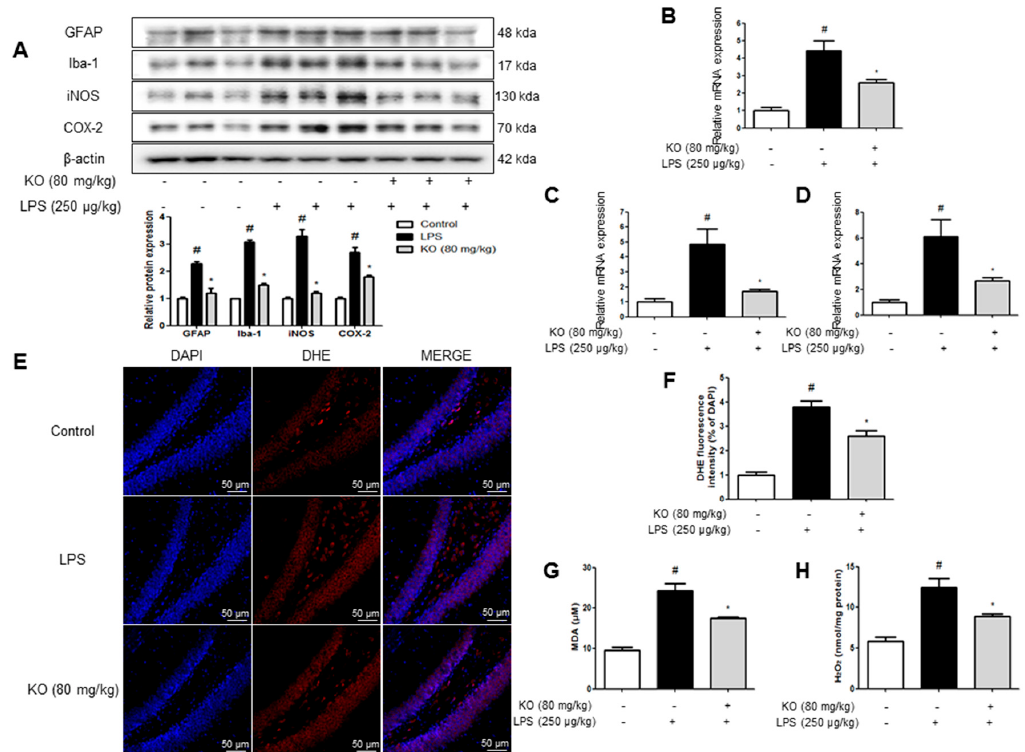
Figure 4. Effect of Krill oil on the LPS-induced neuroinflammation and oxidative stress in the mouse brain. The expression of GFAP, Iba-1, iNOS, and COX-2, were detected by Western blotting using specific antibodies in the mice brain. Each blot is representative of three experiments ( A ). For the cropped images, samples were run in the same gels under same experimental conditions and processed in parallel. The graphs under Western blotting are the relative protein expression of three bands. Each band is representative of three experiments. mRNA levels of IL-6 ( B ); IL-1 β ( C ); and TNF- α ( D ) were detected by qRT-PCR in brain tissues ( n = 5). Intracellular superoxide radical production was measured by dihydroethidium in the brain. The brain sections were double stained with DHE (red) and DAPI staining (blue) ( E ). Similar patterns were observed in five mice brain. The graph is a quantification of the DHA fluorescent signal in the brain tissues ( F ). MDA ( G ); and hydrogen peroxide level ( H ) were assessed by using a specific detection kit as described in Methods ( n = 5). Values measured from each group of mice were calibrated by the amount of protein and expressed as mean ± SD. Group differences were analyzed by one-way ANOVA followed by Bonferroni’s post-hoc analysis. # Significantly different from control group ( p < 0.05). * Significantly different from LPS-treated group ( p < 0.05).